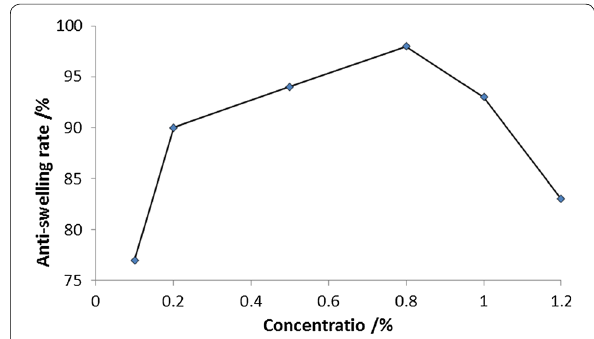
Fig. 2 The effect of DEM-8 concentration on anti-swelling rate